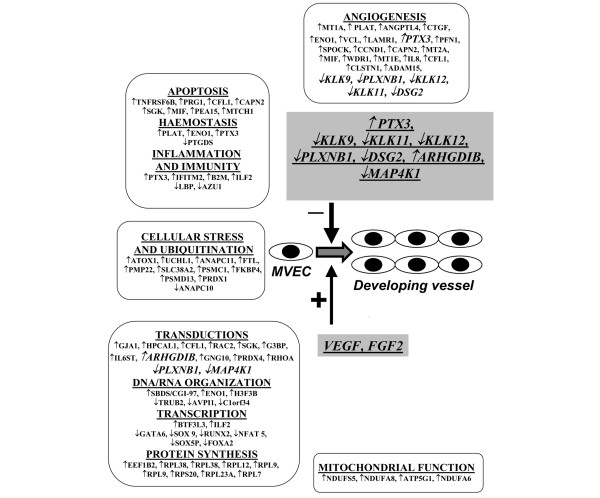
Impairment of angiogenesis in systemic sclerosis. Genes differentially expressed in microvascular endothelial cells (MVECs) from patients with systemic sclerosis (SSc-MVECs) are grouped according to Table 3. Upward and downward arrows indicate up-regulation and down-regulation, respectively, in SSc-MVECs. Differentially expressed genes that we propose to be critical to the altered angiogenic process in SSc are reported in italics in each sub-group. In SSc, the powerful angiogenic instruction of Vascular Endothelial Growth Factor (VEGF) and Fibroblast Growth Factor-2 (FGF2) [34,35] is outstripped by the activity of differentially expressed genes shown as a separate group in the box shaded light grey.